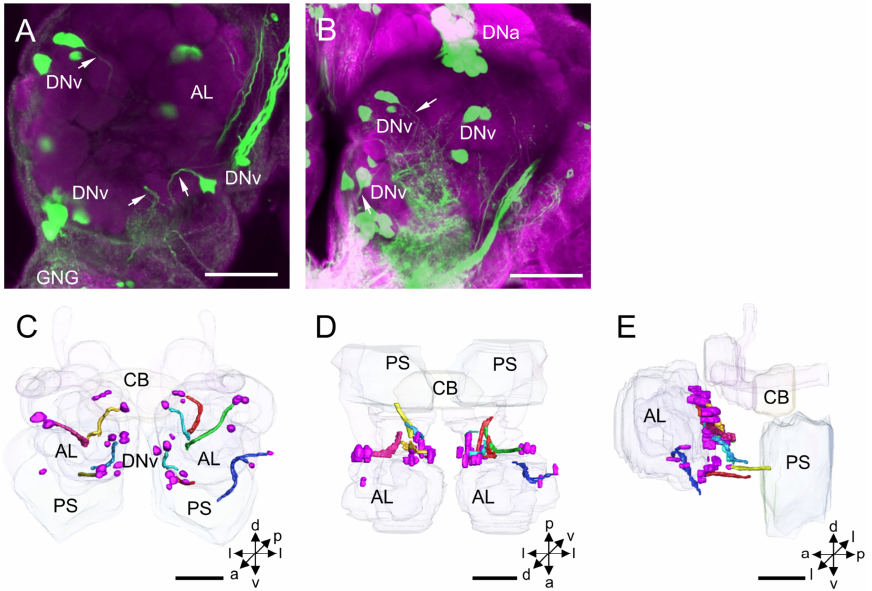
Figure 6. Distribution and projection patterns of DNv neurons in the brain: ( A , B ) projection views of confocal stack images showing DNv somata and primary neurites (arrows); and ( C – E ) the anterior, dorsal, and lateral views of the three-dimensional reconstruction showing DNv somata and primary neurites in the brain. AL, antennal lobe; CB, central body; GNG, gnathal ganglion; PS, posterior slope. a, anterior; d, dorsal; l, lateral; p, posterior; v, ventral. Scale bars: 100 μ m.